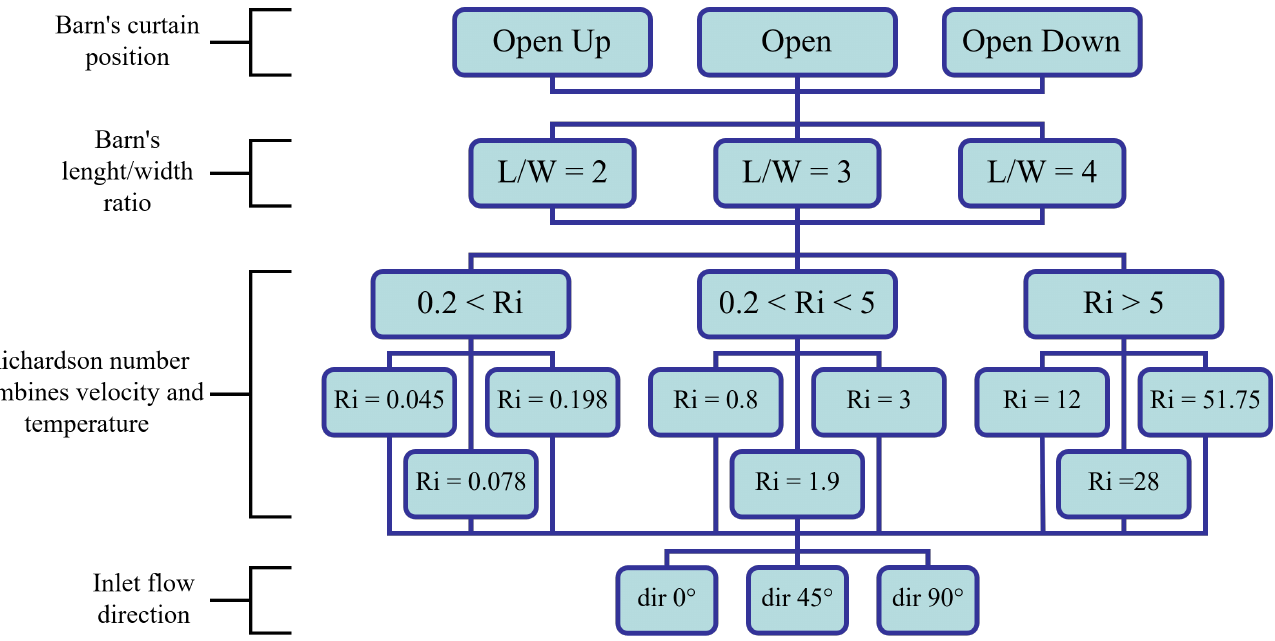
Figure 3. Scheme summarizing all parameters and their